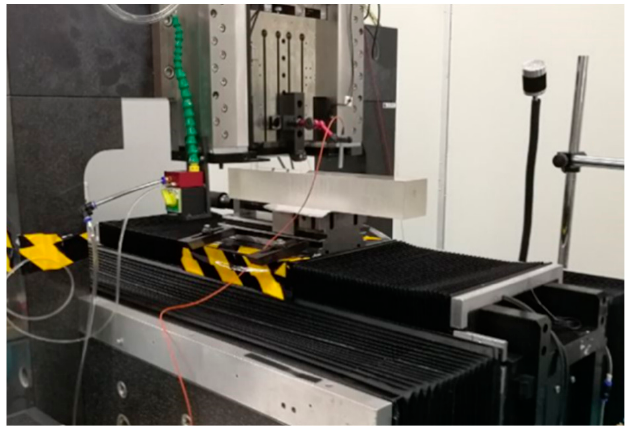
Figure 8. Straightness measurement in X -axis vertical direction.